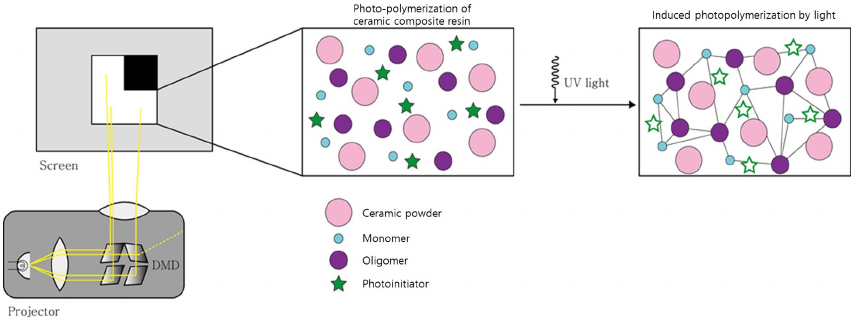
Figure 1. Photo-polymerization of ceramic composite resin.